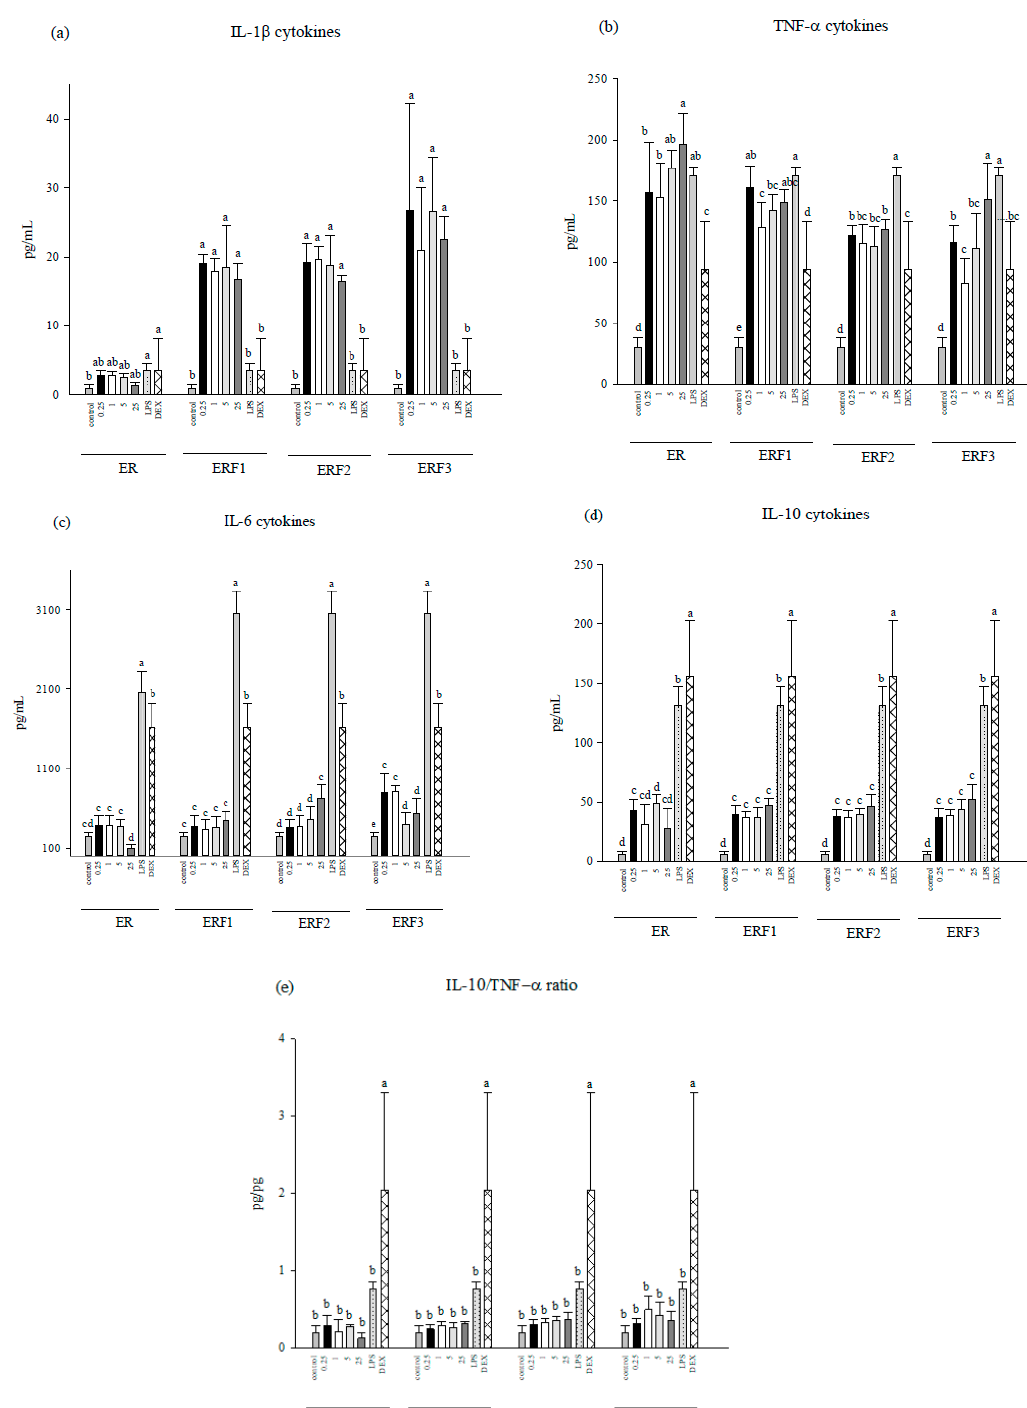
Figure 2. Effect of treatments with different concentrations of steam distilled essential oils of ER, and fractions 1–3 in vitro on IL-1 β ( a ), TNF- α ( b ), IL-6 ( c ), IL-10 ( d ), and IL-10/TNF- α ( e ) cytokine secretions ratios by peritoneal macrophages from female BALB/c mice. Data are presented as the mean ± SD ( n = 6 biological determinations). Bars in the same plot within the same sample item not sharing a common letter are significantly different ( p < 0.05) from each other assayed by one-way ANOVA, followed by DuncaN (cid:48) s multiple range test. Each cell population (1 × 10 6 cells/mL medium) was, respectively, treated with the Euodia ruticarpa (ER) SDEO, and fractions 1–3 at the indicated concentrations of 0, 0.25, 1, 5 and 25 µ g/mL. The detection sensitivity of cytokine ELISA kits used in this study was <15.6